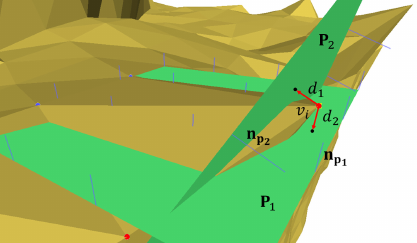
Figure 10. Schematic diagram of the tensile forces of the local support neighborhoods on the feature point. d j is the distance from the feature point v i to the support plane p j , and n p of the j th plane. The tensile forces of the support planes on the shape edge point v i are shown in Equation